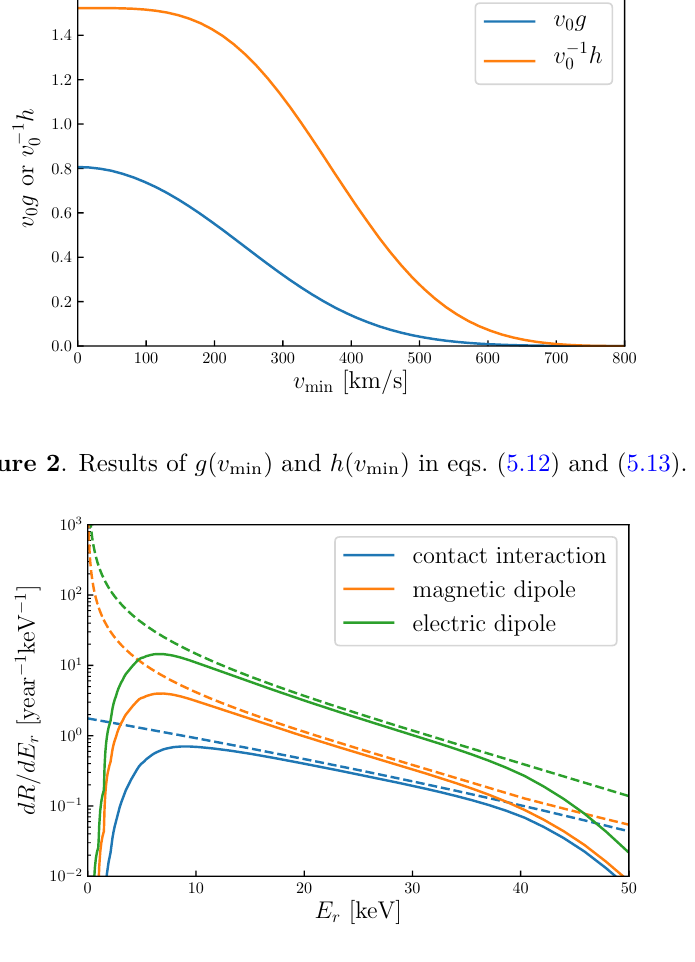
Figure 3 . Event rates for DM-nucleus scattering via magnetic and electric dipoles compared with the standard (contact-interaction) case. Shown examples take d M = 5 × 10 − 20 ecm, d E = 1 × 10 − 22 ecm, σ n = 10 − 46 cm 2 , and m χ = 100 GeV. Dashed curves assume ideal detection efficiency and solid curves take the XENON-1T detection efficiency [10] into